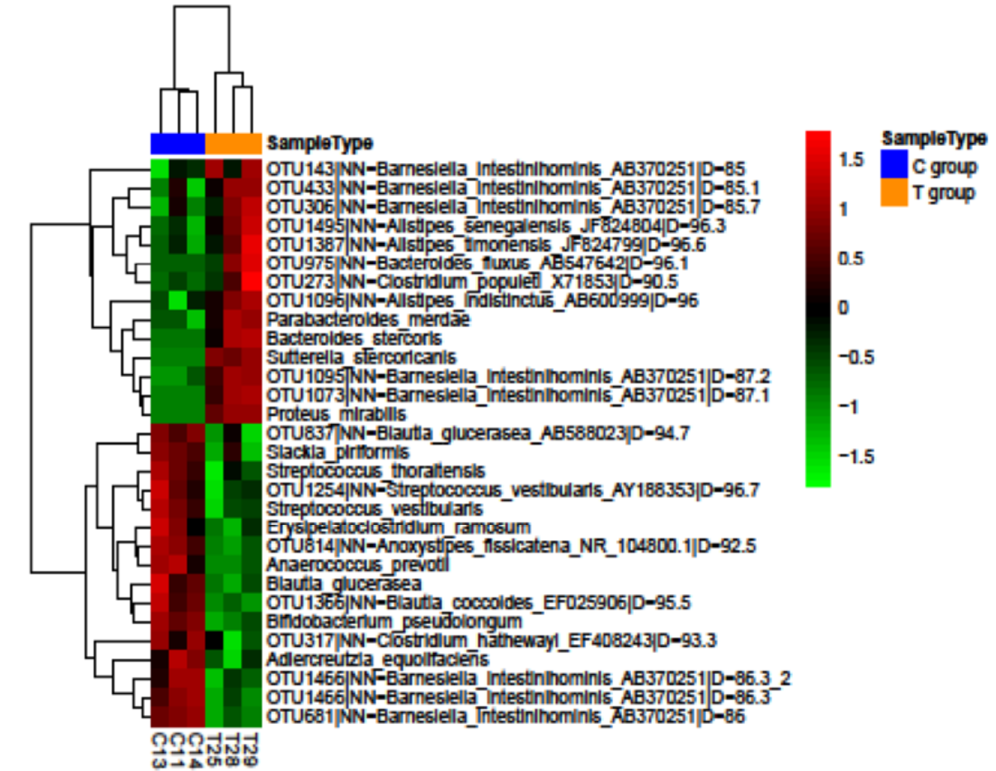
Figure 7. Hierarchical clustering. Hierarchical clustering of differentially abundant species ( p < 0.05)